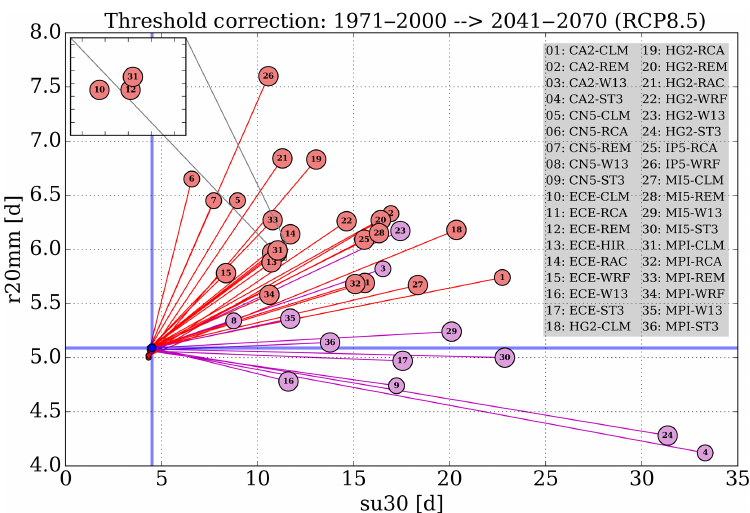
Figure 5. Scatterplot of the projected number of hot days (su30) and very wet days (r20mm) using threshold adjusted RCM (red) and ESD (magenta) simulations until 2041–2070 (RCP8 . 5). The simulations are numbered for reference in the right-hand tabulation. The window in the top left corner enlarges the a segment of the graph near the label for model chain 31 (MPI-CLM) where several labels are overlapping. Thick blue lines mark the baseline period (1971–2000) conditions for su30 and